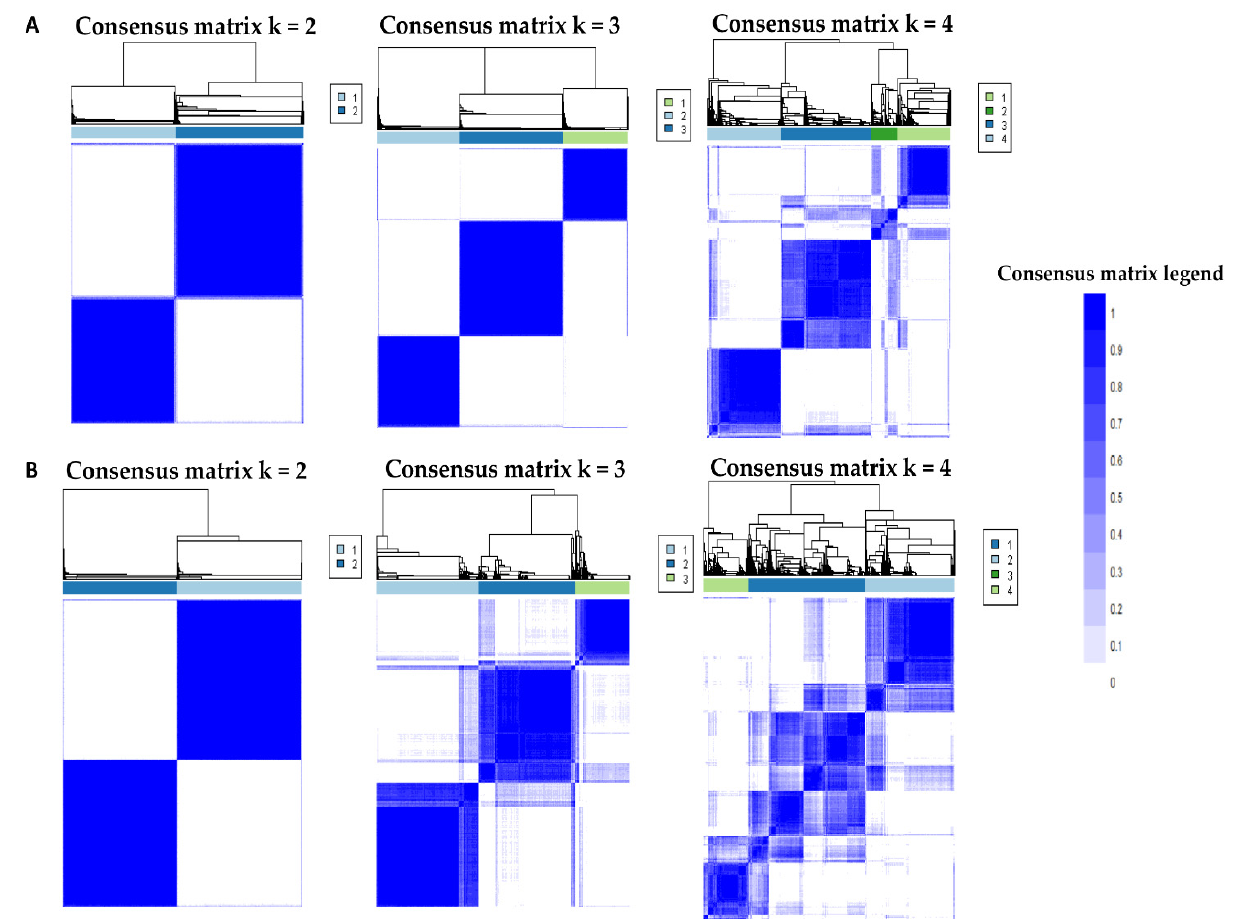
Figure 2. ( A ) Consensus matrix heat map depicting consensus values on a white to blue color scale of each cluster (k) for patients with hypomagnesemia; ( B ) Consensus matrix heat map depicting consensus values on a white to blue color scale of each cluster (k) for patients with hypermagnesemia.